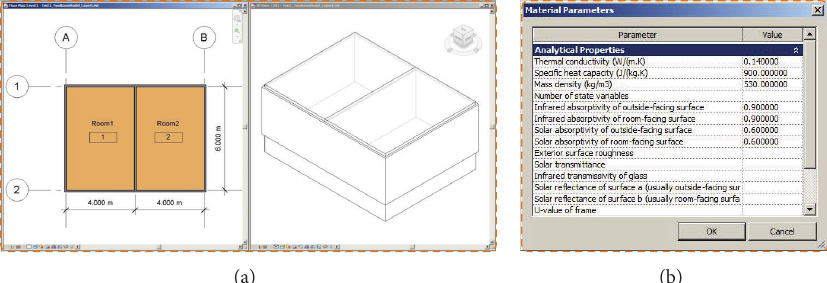
Figure 8: A two-thermal-zone Revit model. (a) Floor-plan and isometric views. (b) The custom parameter window for adding additional physical properties.